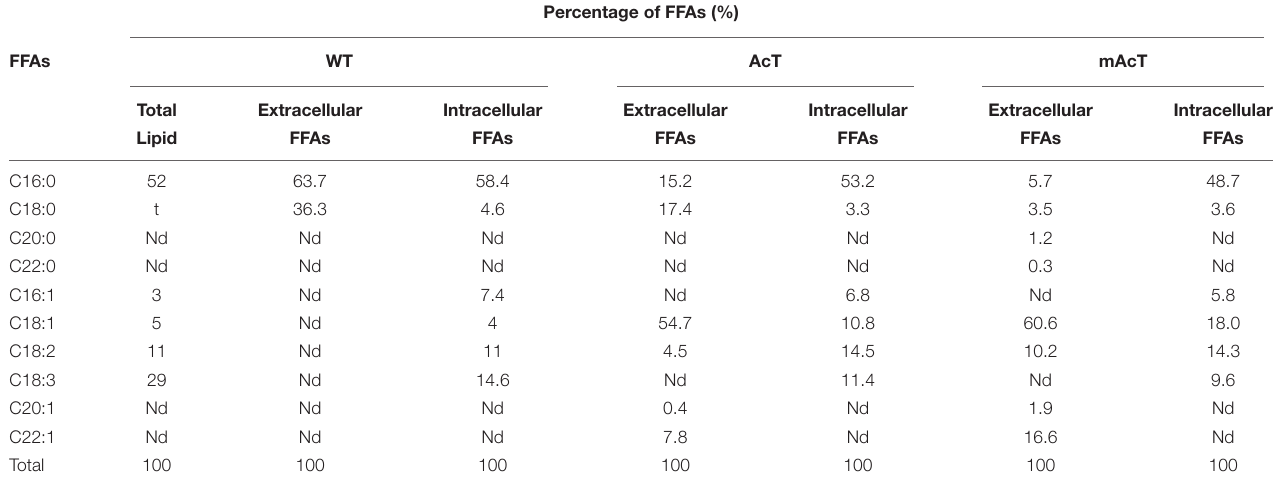
TABLE 3 | FFAs profile of WT, AcT, and mAcT strains analyzed by GCMS. Percentage of FFAs (%) FFAs AcT mAcT Extracellular Intracellular Extracellular Intracellular Extracellular